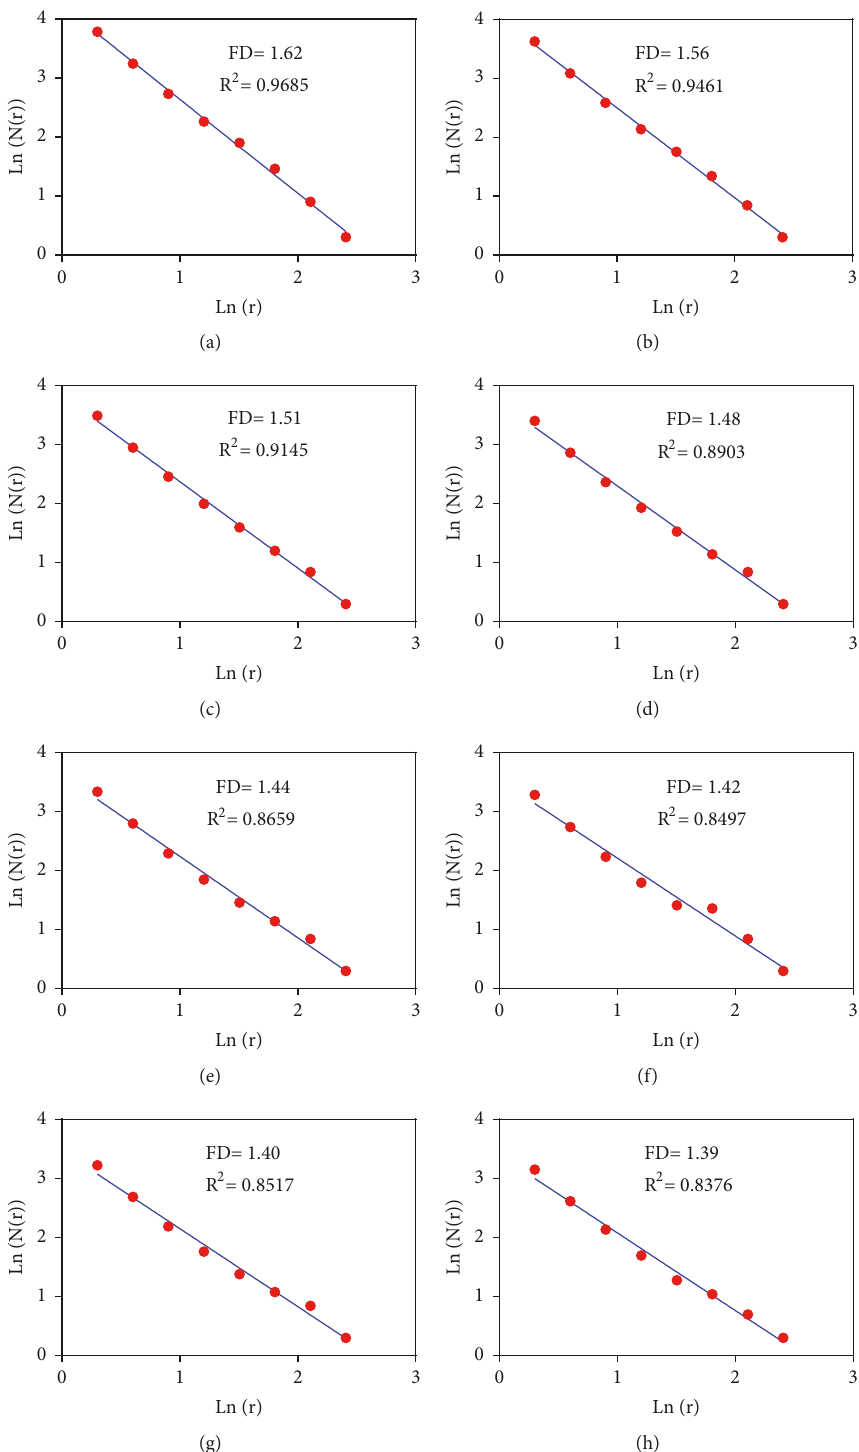
Figure 10: Fractalyse2.4 plots showing thenumberof boxes N(r)against boxside length(r) onlogarithmic scales for eachmapin Figure 7. (a) Ω .m; (b) (cid:2) Ω .m; (c) (cid:2) Ω .m; (d) (cid:2) Ω .m; (e) (cid:2) Ω .m; (f) (cid:2) Ω .m; (g) (cid:2) Ω .m; (h) (cid:2) Ω (cid:2) a . r = 200 a . r = 220 a . r = 240 a . r = 260 a . r = 280 a . r = 300 a . r = 320 a . r = 340